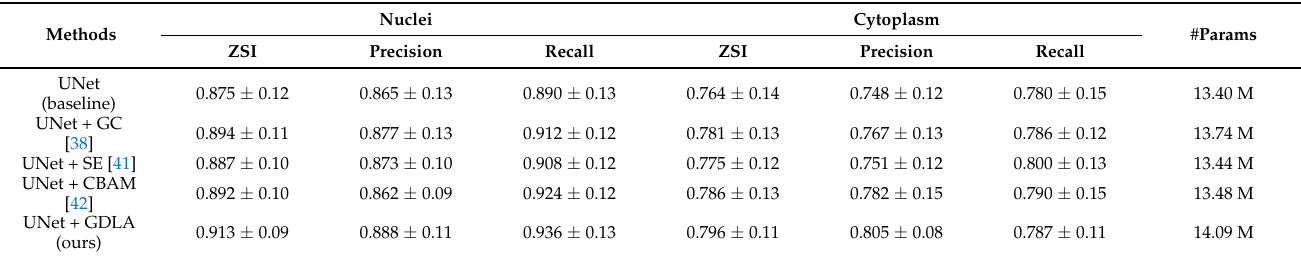
Table 1. The effect of different modules, including GC unit, SE unit, CBAM module, and GDLA module, on network performance. The values are in the format of µ ± σ .